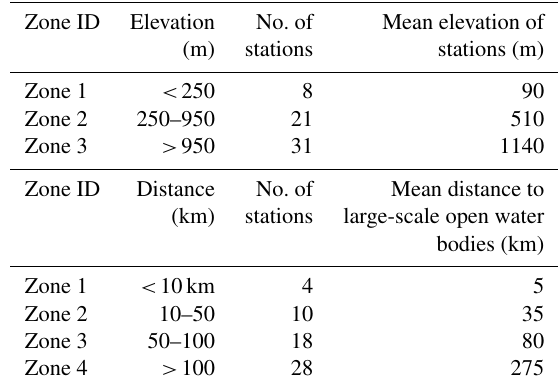
Table 1. Elevation and distance from large-scale open water